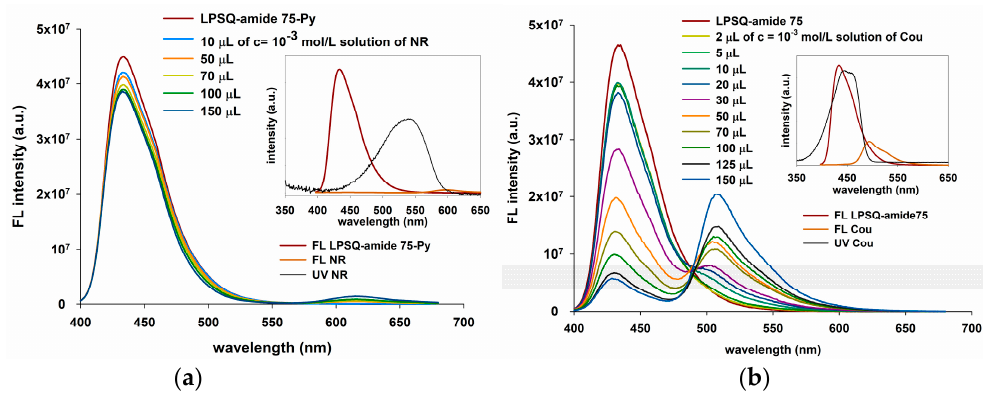
Figure 15. Energy transfer from LPSQ-amide75-Py to ( a ) Nile Red and ( b ) Coumarin 6 (insets: spectral overlap of LPSQ derivatives and dyes; measurements as described in Materials and Methods).